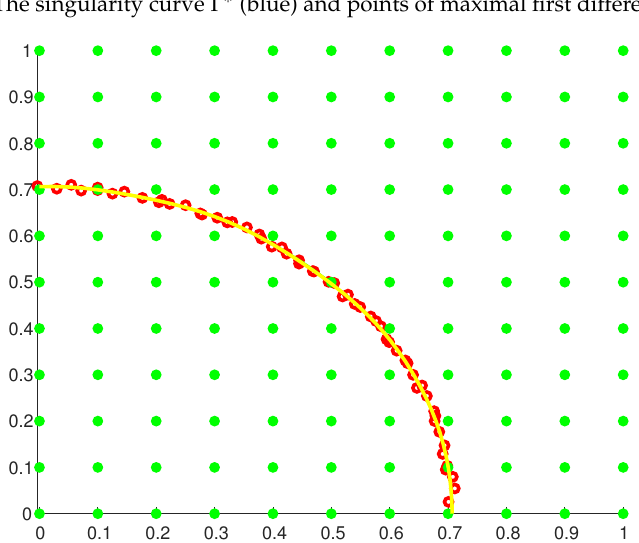
Figure 14. The singularity curve Γ ∗ (blue) and points of maximal first differences of f 50